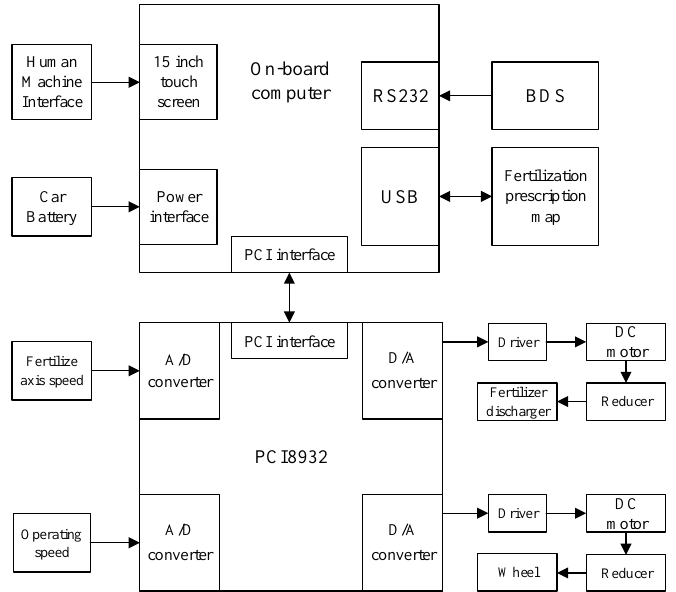
Figure 3. Principle of fertilization platform.